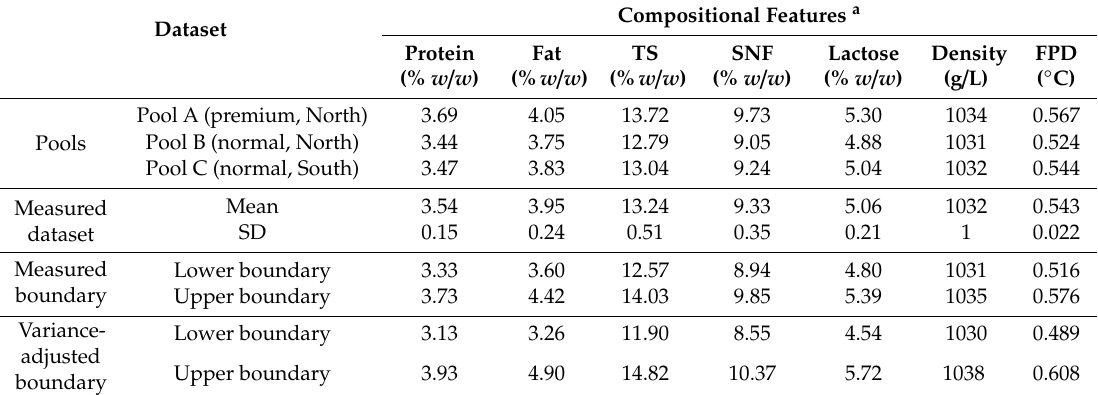
Table 1. Means and standard deviation (SD) of the compositional features of the control samples measured by standardised Fourier transform-infrared spectroscopy and the boundaries based on the measured dataset and variance-adjusted